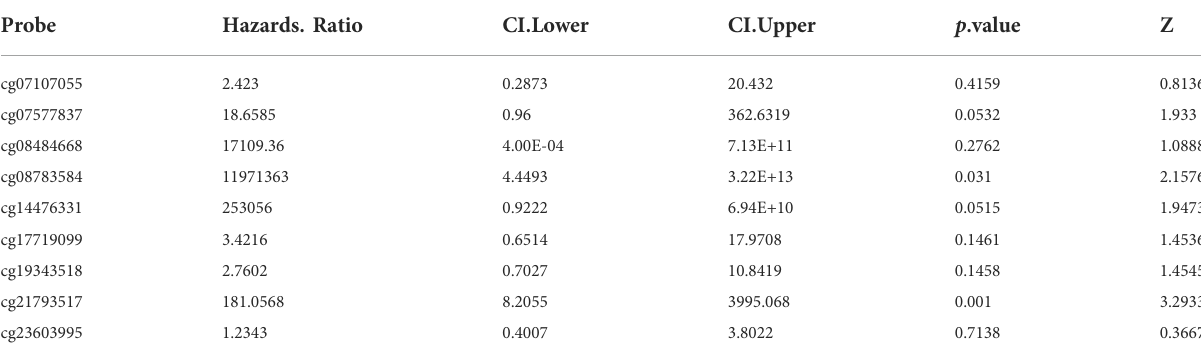
TABLE 1 Univariate